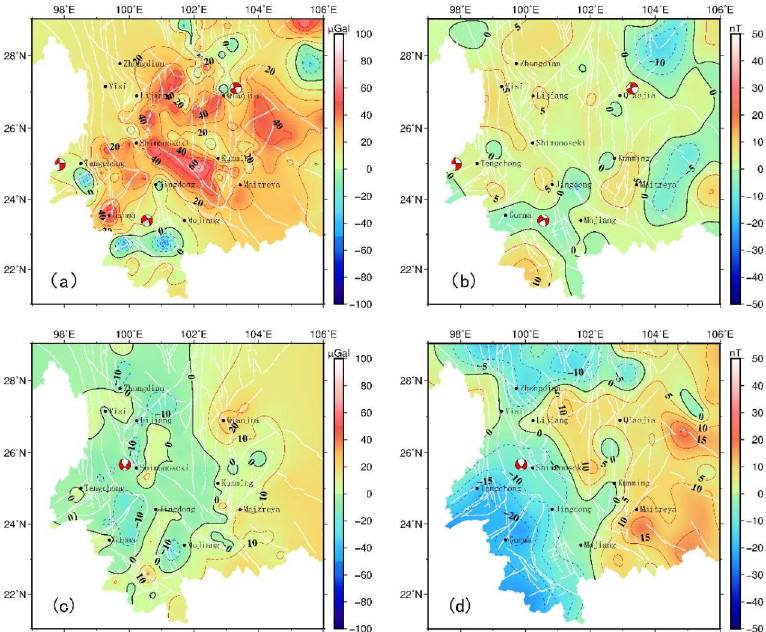
Figure 1. The spatial distribution of the annual difference in gravity and magnetic anomaly fields for each of the two years that precede strong earthquakes in the Yunnan area. ( a ) Annual changes in gravity from 2013 to 2014; ( b ) Annual changes in total geomagnetism from 2013 to 2014; ( c ) Annual changes in gravity from 2019 to 2020; ( d ) Annual changes in geomagnetism from 2019 to 2020. Epicenter and focal mechanism are shown for earthquakes that occurred within a year of the respective time period